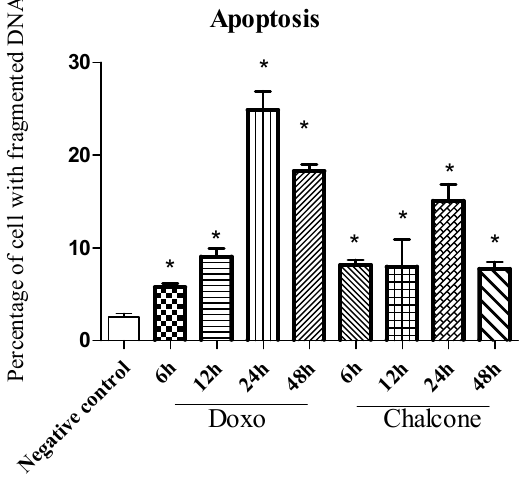
Figure 4. Percentage of PC-3cells with fragmented DNA as assessed by Flow Cytometry, indicating the end of the apoptosis process induced by treatment with the isolated cardamonin. Values are the mean ± SD ( n = 5). * = p < 0.05, ANOVA followed by the Tukey test, compared with the negative control—cells cultived with diluent for 48 h.